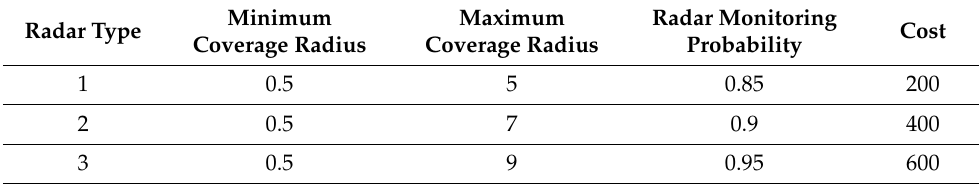
Table 3. Coefficients of radar to be